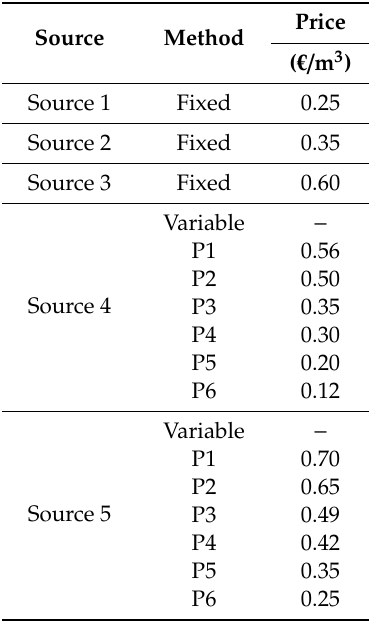
Table 2. Water prices as a function of the di ff erent sources according to [39].